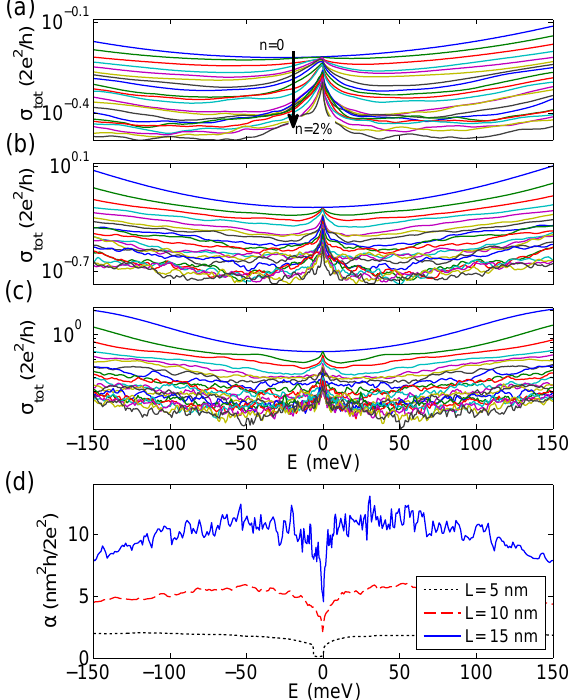
Figure 9. Total conductivity for aGNRs with W = 150 nm, n ( b ) L = 10 nm and ( c ) L = 15 nm; ( d ) Coefficient of the linear dependence of the extrinsic resistivity as a function of the compensated vacancy